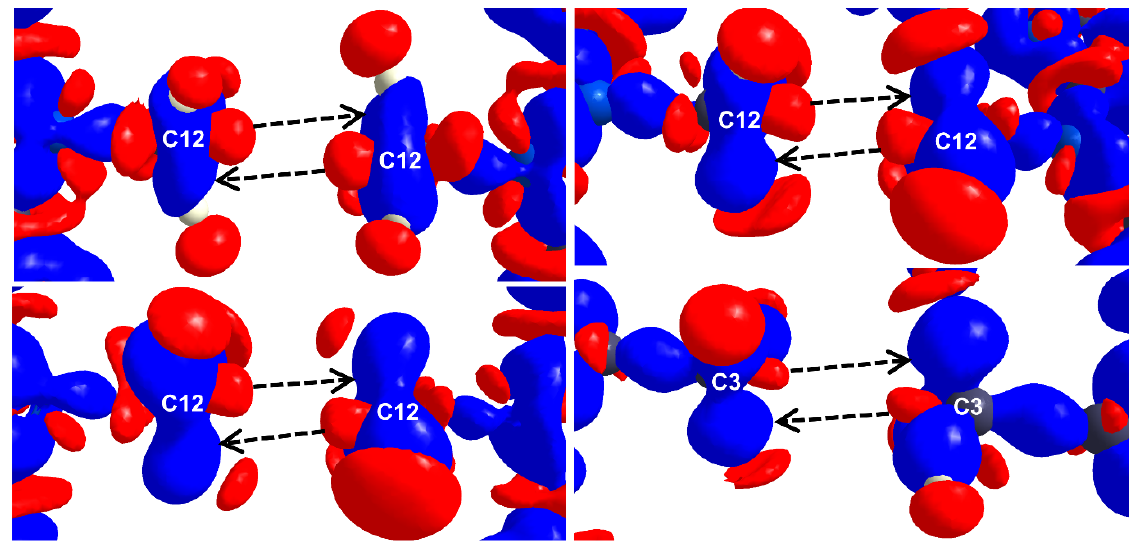
Figure 17. Experimental 3D deformation density maps for Caff-3HNA ( top left ), Caff-PZCA ( top right ), Theo-25DFBZA ( bottom left ), TMP-OA (Me3) ( bottom right ) plotted at a contour level of 0.08 eÅ − 3 . The blue region indicates charge concentration regions while red region indicates charge depleted regions, respectively. Reprinted with permission from reference. Ref. [78] Copyright 2019, American Chemical Society.